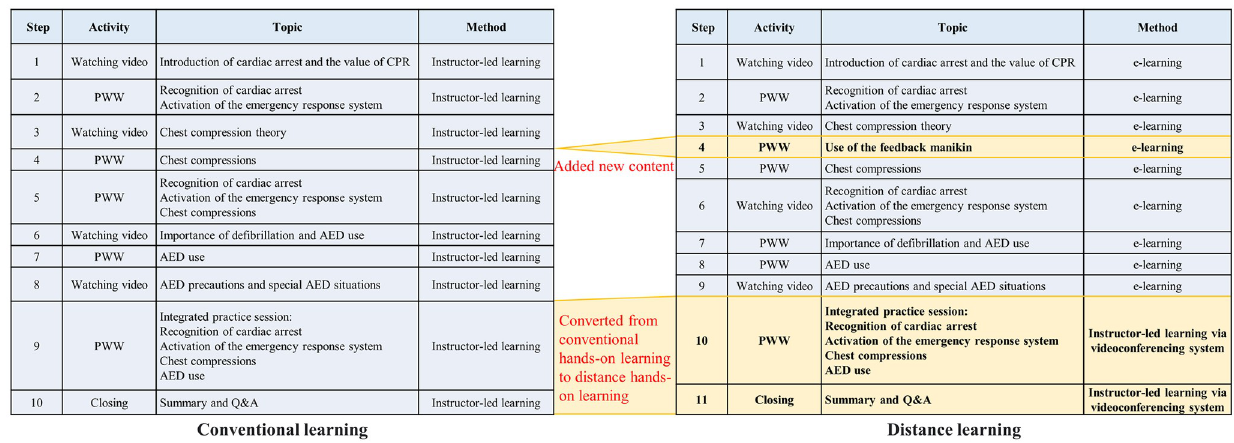
Fig 1. Training schemes for the conventional learning course and distance learning course. AED, automated external defibrillator; CPR, cardiopulmonary resuscitation; PWW, practice-while-watching.